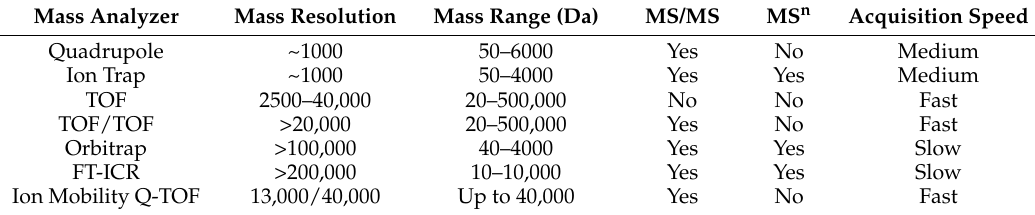
Figure 4. Identification of molecular formula using uHRMS in combination with isotopic fine structure: ( A ) Full Scan MS + spectra for a glutathione standard showing three calculated formula matches within 2 ppm mass error; ( B ) Expansion of m/z 309.07–309.13 showing M + 1 isotopologues and inability to determine parent formula; ( C ) Expansion of m/z 310.06–310.13 showing M + 2 isotopologues with calculated isotopic fine structure match of 34 S, 18 O and 13 C 2 isotopologues to C 10 H 17 N 3 O 6 S matching the glutathione standard, other formula fine structures do not match the same isotopologue profile. Table 1. List of common mass analyzers and instrument configurations detailing: mass resolution, approximate mass range, tandem MS/MS capabilities and acquisition speed. TOF = Time of Flight, TOF/TOF = Tandem TOF, IT = Ion Trap, FT-ICR = Fourier Transform Ion Cyclotron Resonance, Q-TOF = Quadrupole Time of Flight, Da = Dalton.